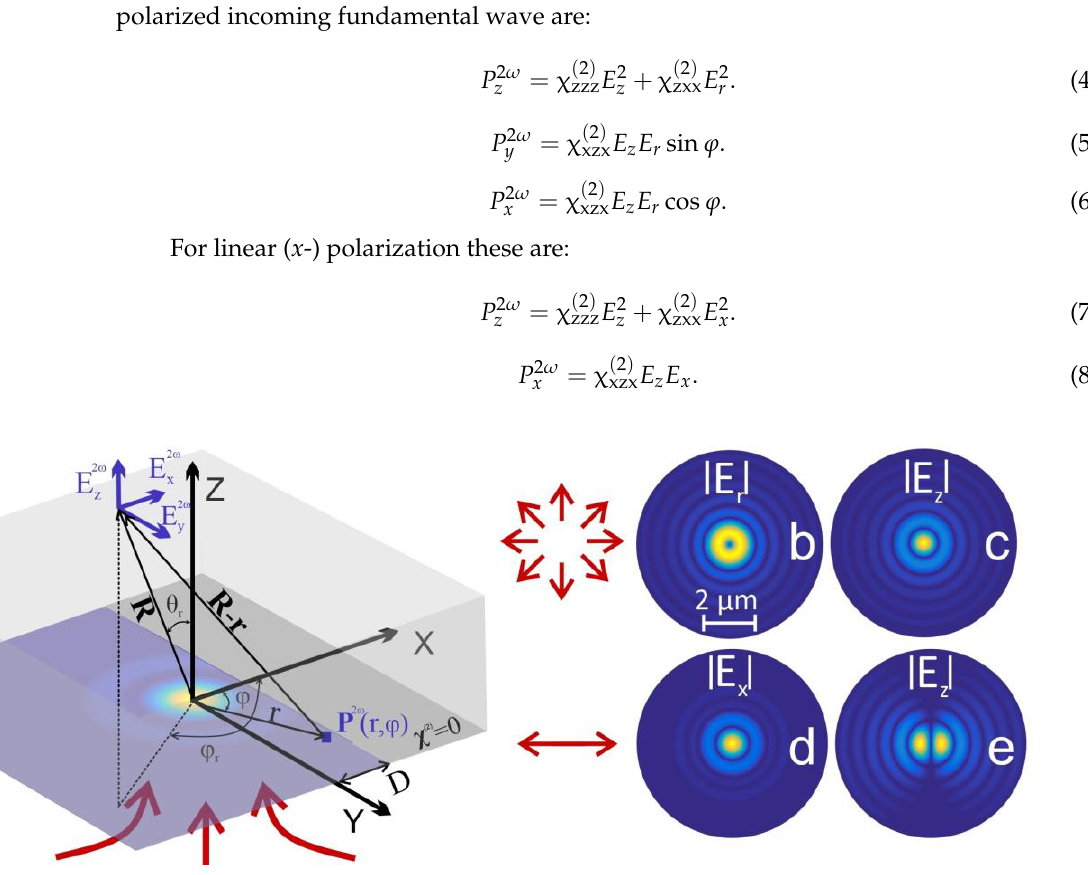
Figure 1. ( a ) Scheme of the problem; color map represents a typical | P 2 ω |-distribution; D varies in our calculations; negative D corresponds to the beam center falling over the edge; the arrows indicate direction of excitation. Distributions of r - ( b ) and z -components ( c ) of E -field of the radially polarized fundamental wave and x - ( d ) and z -components ( e ) of E -field of the linearly ( x -) polarized fundamental wave in the focal plane; the arrows schematically indicate